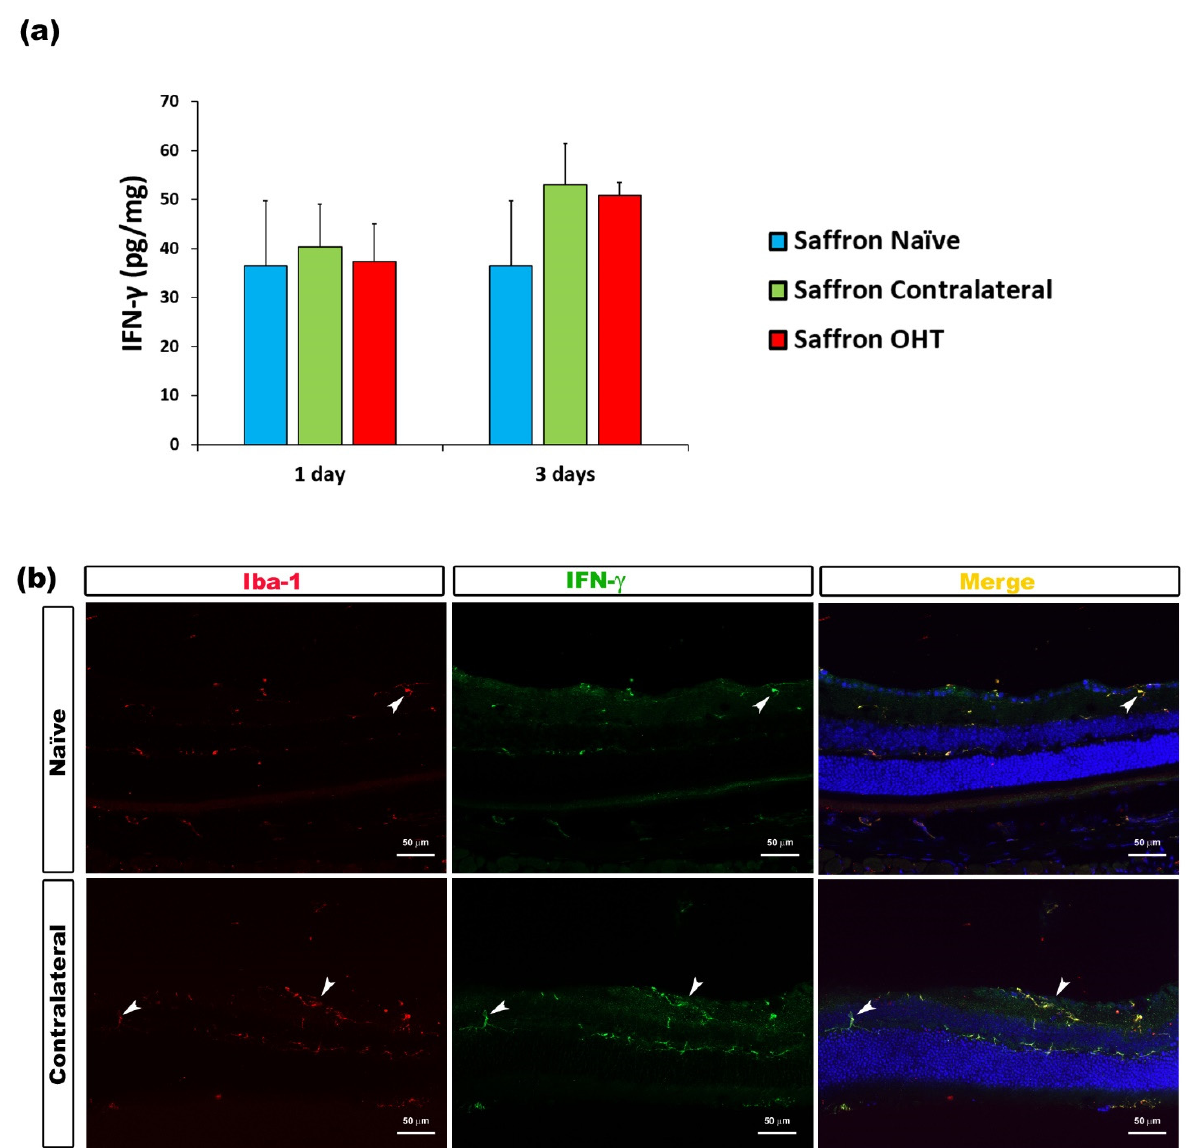
Figure 4. IFN- γ levels at 1 and 3 days after laser-induced ocular hypertension (OHT). ( a ) The IFN- γ values obtained in the multiplex assay. The histogram shows the mean levels ( ± SD) of IFN- γ (pg/mg) at days 1 and 3 after laser OHT induction in saffron ocular hypertension eyes (saffron OHT), saffron-contralateral eyes (saffron-contralateral), and saffron-naïve eyes. ( b ) Immunohistochemical study of IFN- γ expression in saffron-contralateral eyes three days after unilateral laser-induced OHT. Retinal sections were immunolabeled with antibodies to IFN- γ (green) and Iba-1 (red). Merge is denoted with the colour yellow. The arrowhead shows the co-expression of Iba-1 and IFN- γ in saffron-contralateral and saffron-naïve eyes. Abbreviations: OHT (ocular hypertension); IFN- γ (interferon- γ ); Iba-1 (ionized calcium-binding adaptor molecule).